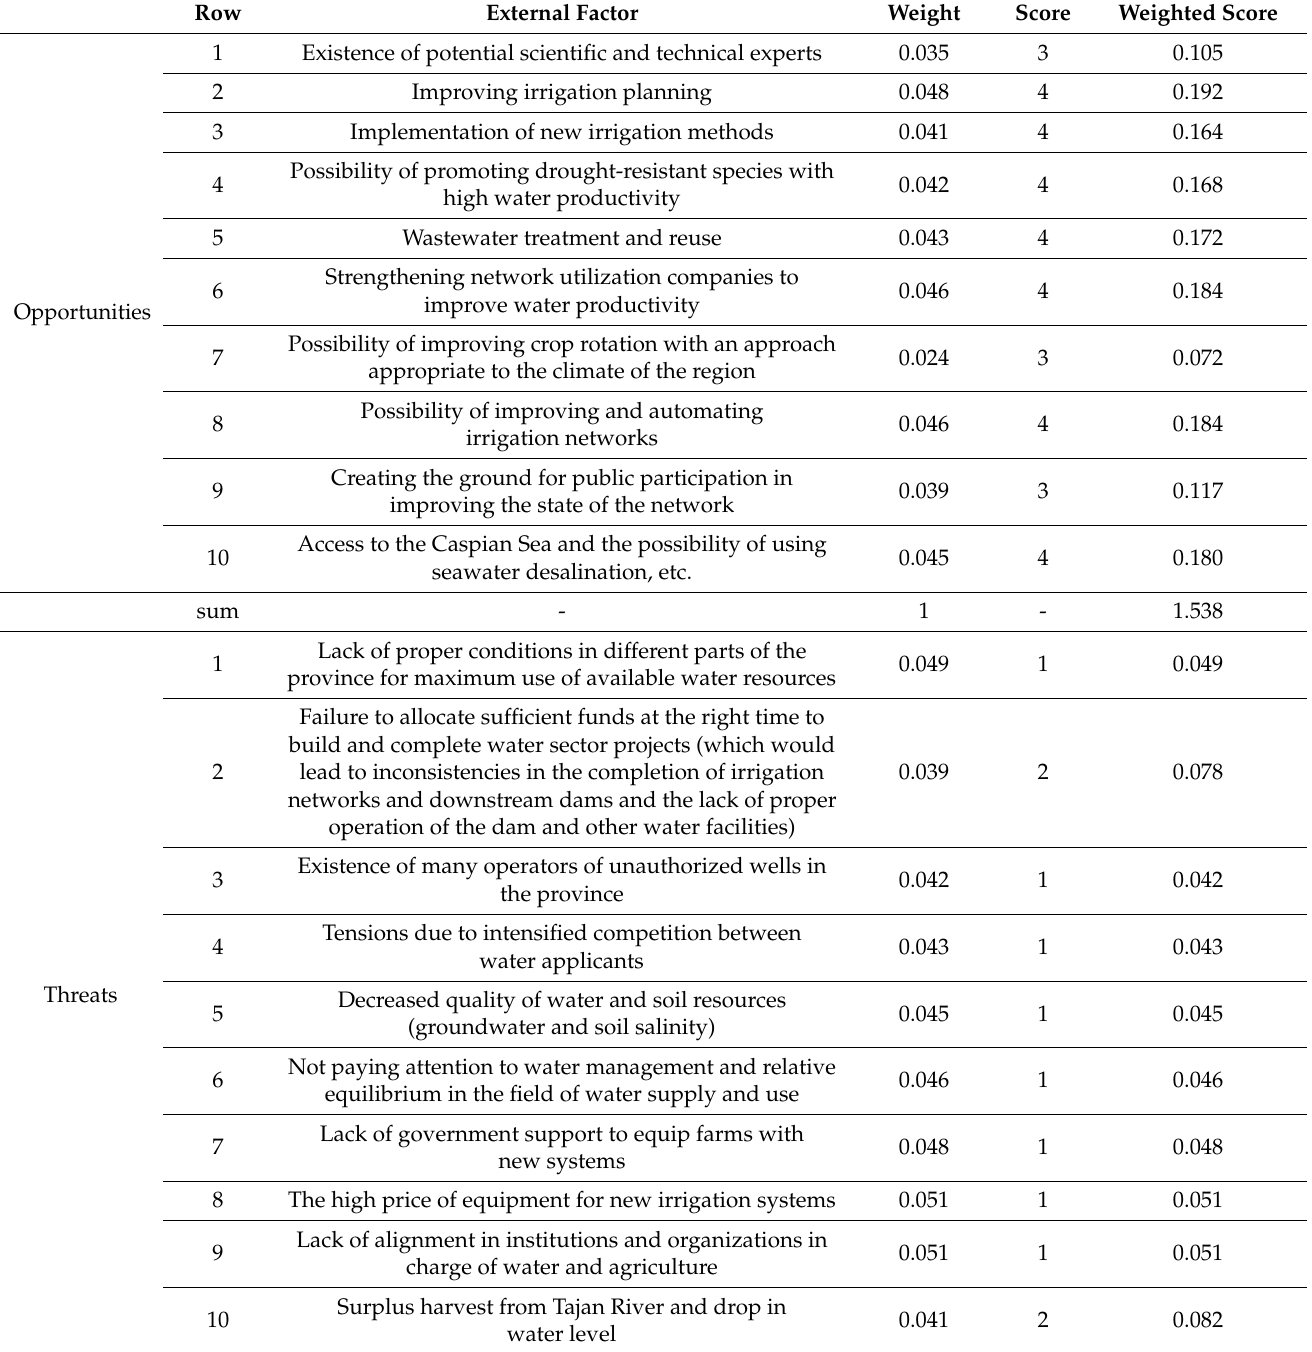
Table 2. External Factor Analysis Summary (EFAS) to improve water productivity. Row External Factor Weight Score Weighted